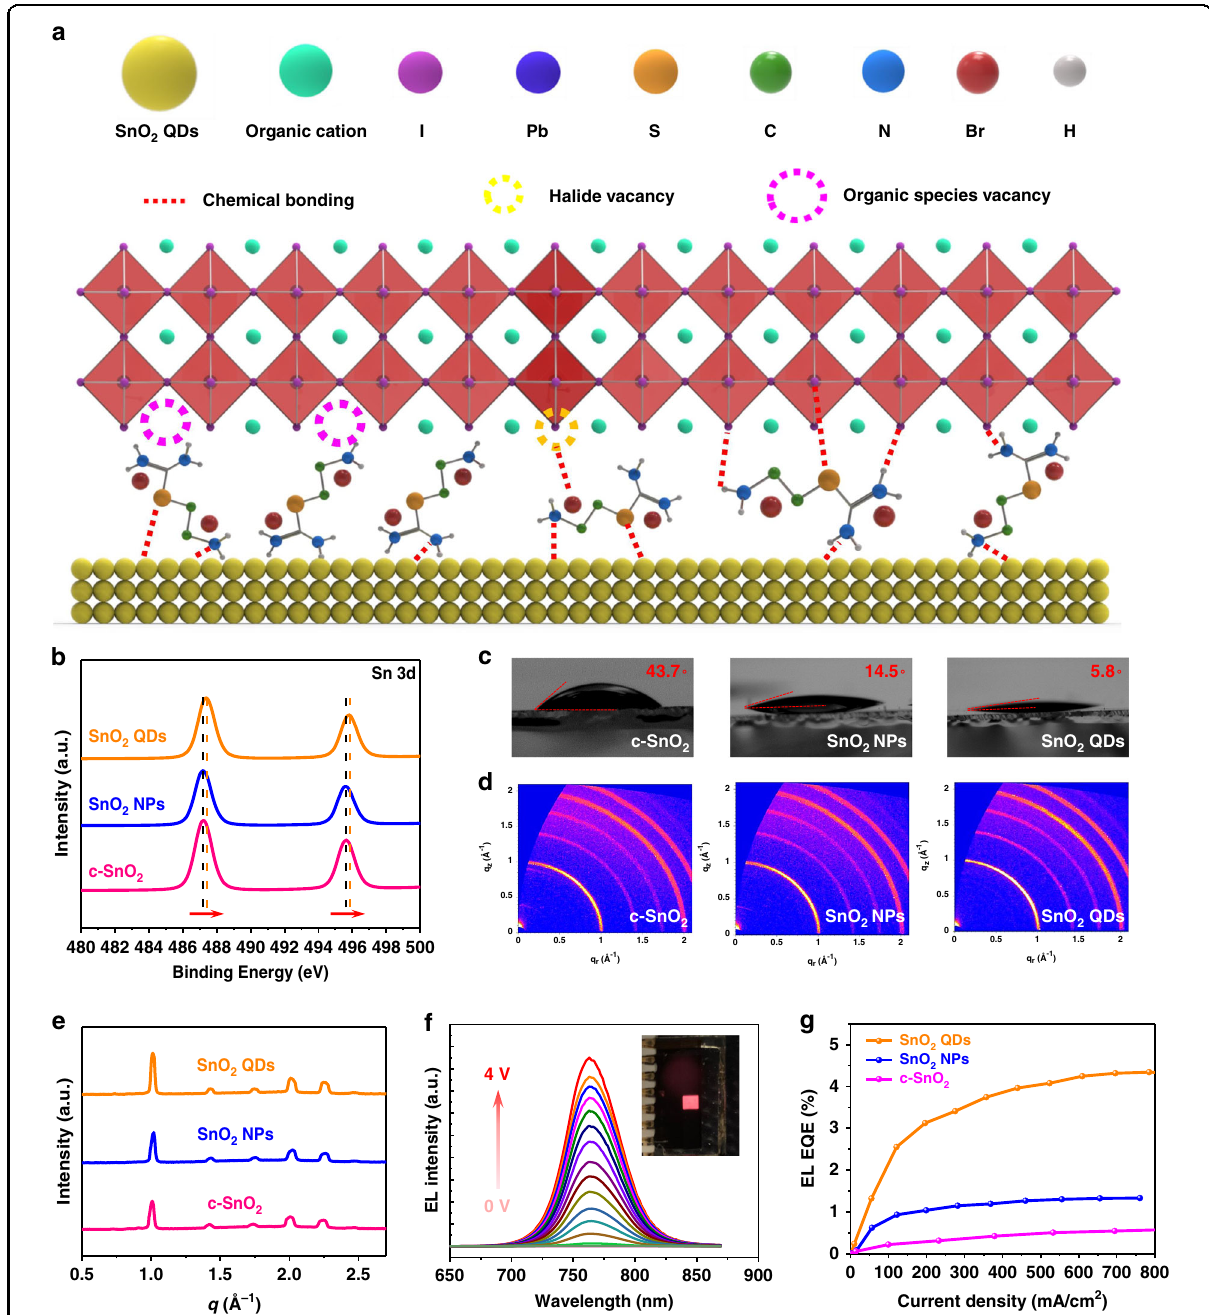
Fig. 3 Passivation mechanism and spectroscopic characterization of perovskite fi lms/devices with ligand-tailored SnO 2 QDs. a Schematic illustration of proposed in situ interfacial defect passivation induced by utilizing ligand-tailored SnO 2 QDs. b XPS core-level spectra of Sn 3 d on c-SnO 2 , SnO 2 NPs, and SnO 2 QDs fi lm. c The deionized water contact angles of various ETLs coated FTO substrates. d GIWAXS patterns of the perovskite fi lms deposited on various ETLs coated quartz substrates. e The diffraction features of the corresponding intensity as a function of q . f EL emission spectra from SnO 2 QD-based PSCs under different voltage bias. The inset displays a bright red emission (~770 nm) operating as a light- emitting diode (LED). g The plot of ELQE as a function of the injection current